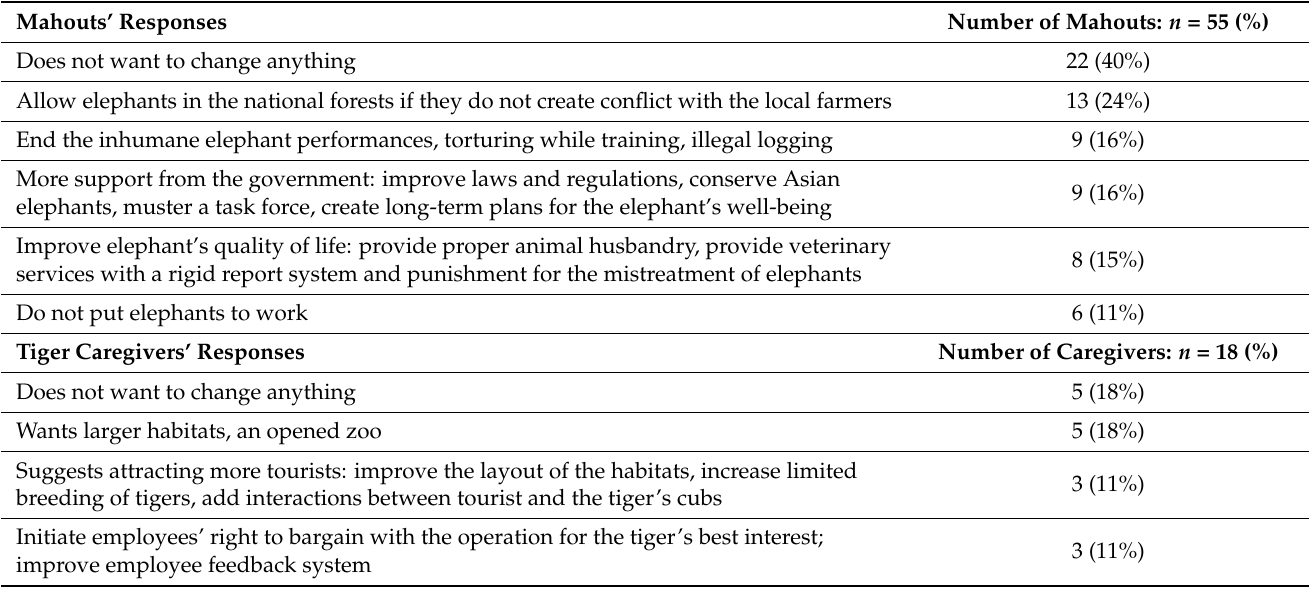
Table 8. Caregivers’ responses for suggested improvements in animal welfare (unlimited choices; each response provided by at least 10% of